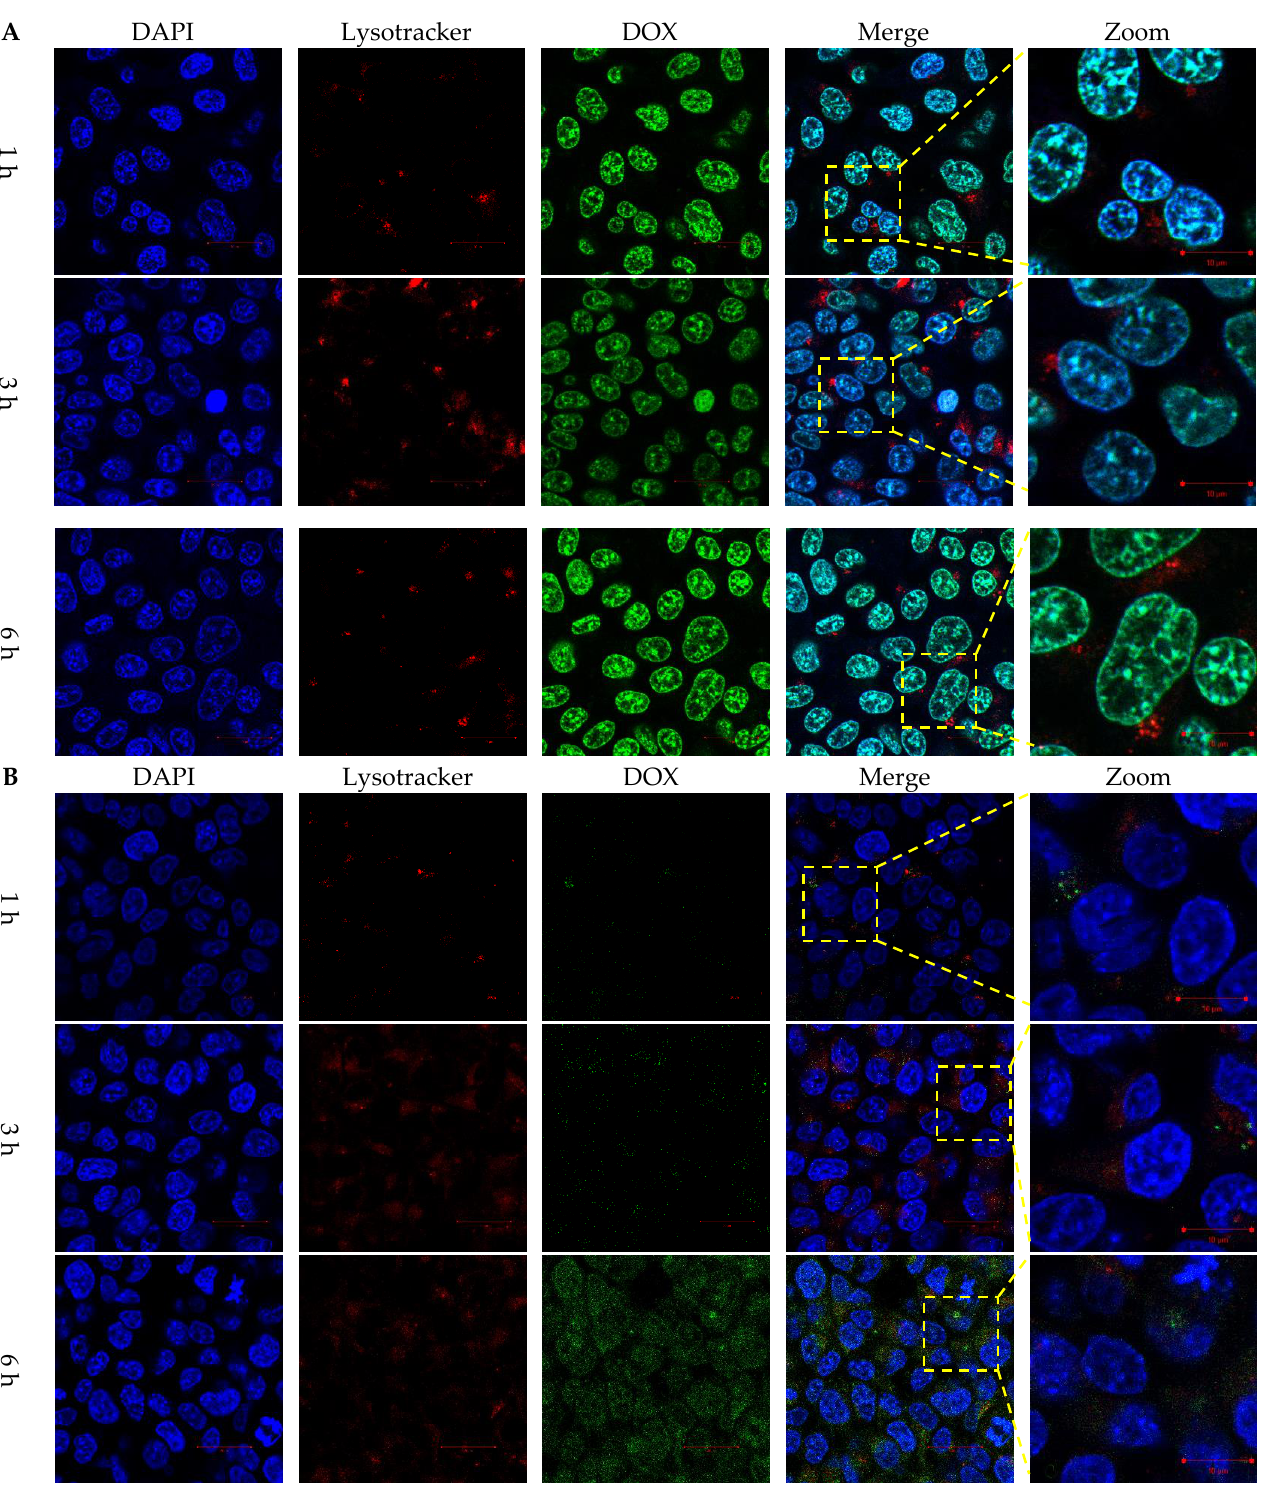
Figure 4. Cytosol delivery behaviors of siRNA from lipopolyplexes. Confocal images of HCT116 cancer cells treated with ( A ) free siRNA and ( B ) LP for 1, 3 and 6 h. The blue, red and green colors represented DAPI-stained nuclei, lysotracker stained lysosome, and siRNA-FAM, respectively. The white arrow indicated that the release of siRNA. The scale bars were 20 μm.